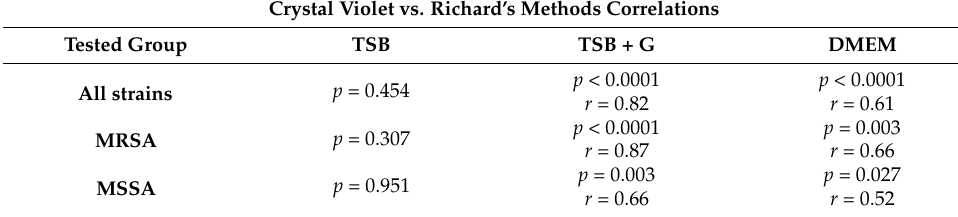
Table 1. Results of correlations between the ability to form biofilm assessed with the crystal violet method (CV) and bacterial metabolic activity measured with Richard’s method (RM) calculated for all tested strains and separately for methicillin-susceptible Staphylococcus aureus MSSA and methicillin- resistant Staphylococcus aureus MRSA strains cultured in tryptic soy broth TSB, tryptic soy broth with 1% glucose TSB + G, and Dulbecco’s Modified Eagle Medium DMEM; r —correlation coefficient and p —probability